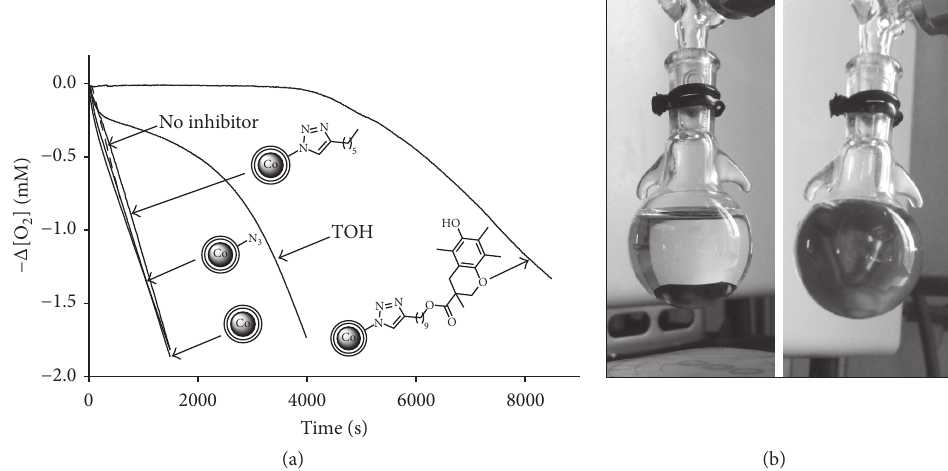
Figure 5: (a) Oxygen consumption during the autoxidation of styrene (4.3 M) in PhCN initiated by AIBN (25 mm) at 30 ∘ C without inhibitor, 3.8 𝜇 M of TOH or with 0.15 mgmL −1 of various CoNPs without the phenolic moiety, and CoNPsTOH (corresponding to a concentration of TOH groups of 14.4 𝜇 M); 𝑅 𝑖 = 3.6 × 10 −9 Ms −1 . (b) Photographs of the reaction vessels of the pressure transducer apparatus containing the CoNPs in the absence (left) and in the presence (right) of magnetic stirring. Reprinted with permission from